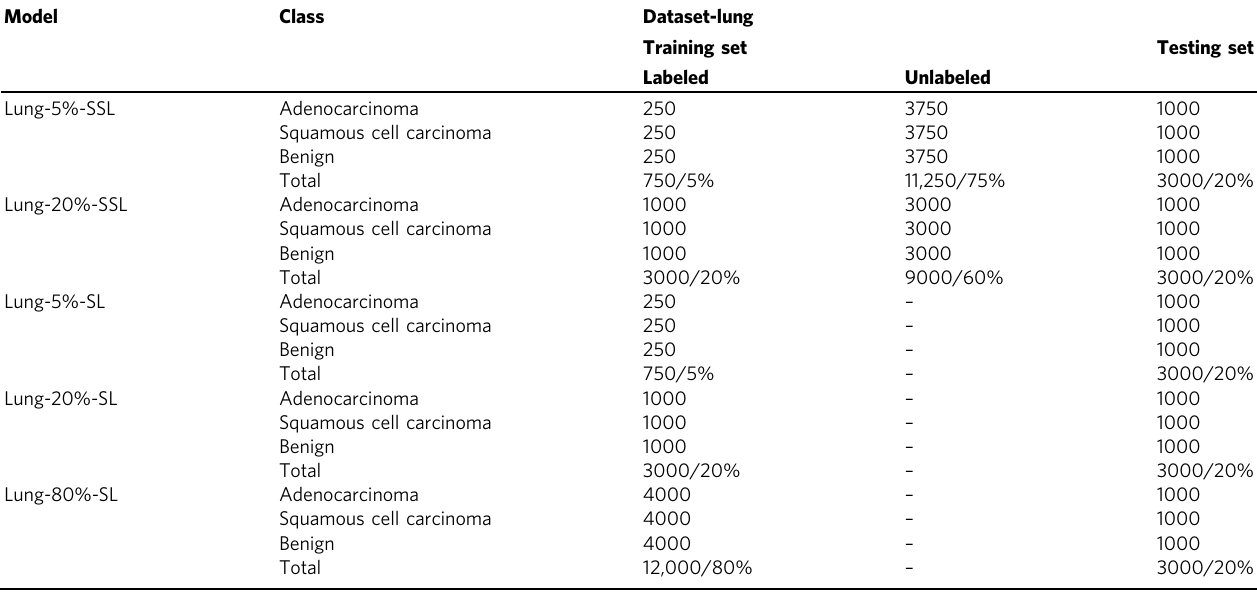
Table 3 Training and testing set for lung models.